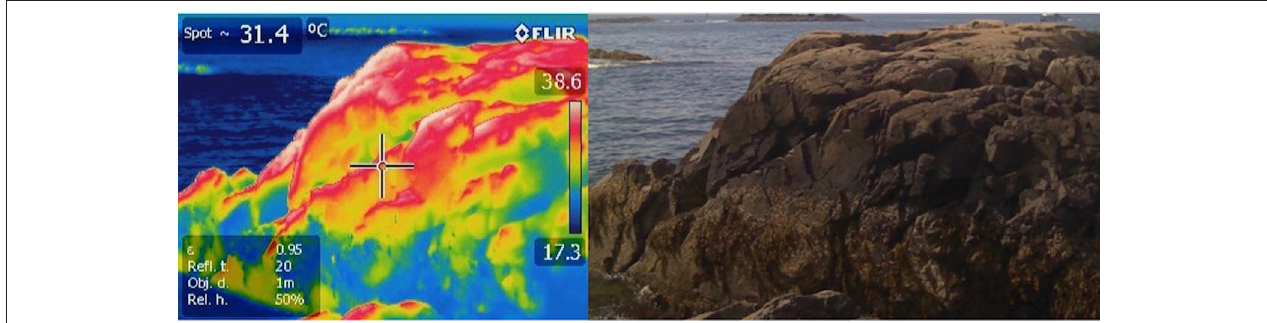
FIGURE 2 | Infrared thermograph of a rocky intertidal site in Nahant, MA USA. Rocky intertidal temperatures range significantly based on complex topography that creates microclimates. These include both areas of high thermal risk and areas of thermal refugia.